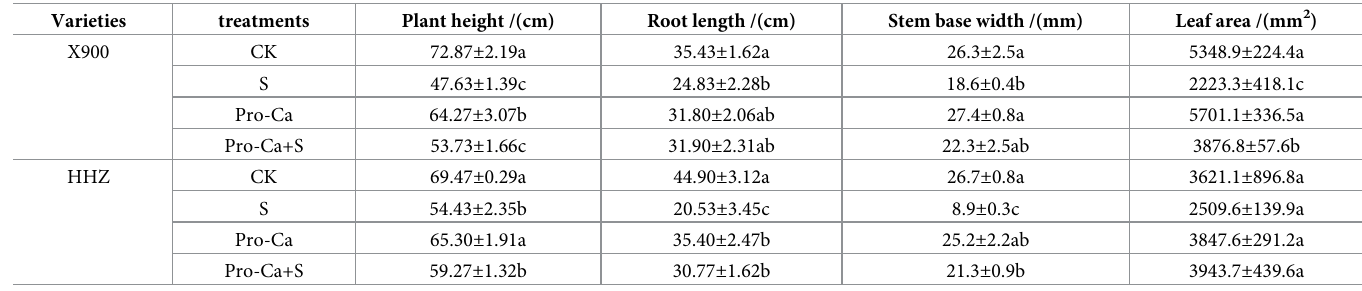
Values represent the mean ± SE ( n = 3), and different lowercase letters indicate significant differences according to Duncan’s